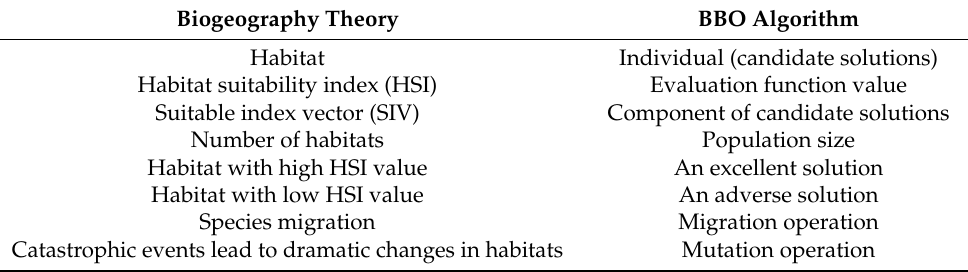
Figure 1. Diagram of species migration between habitats. Table 1. Correspondence between BBO algorithm and biogeography theory.